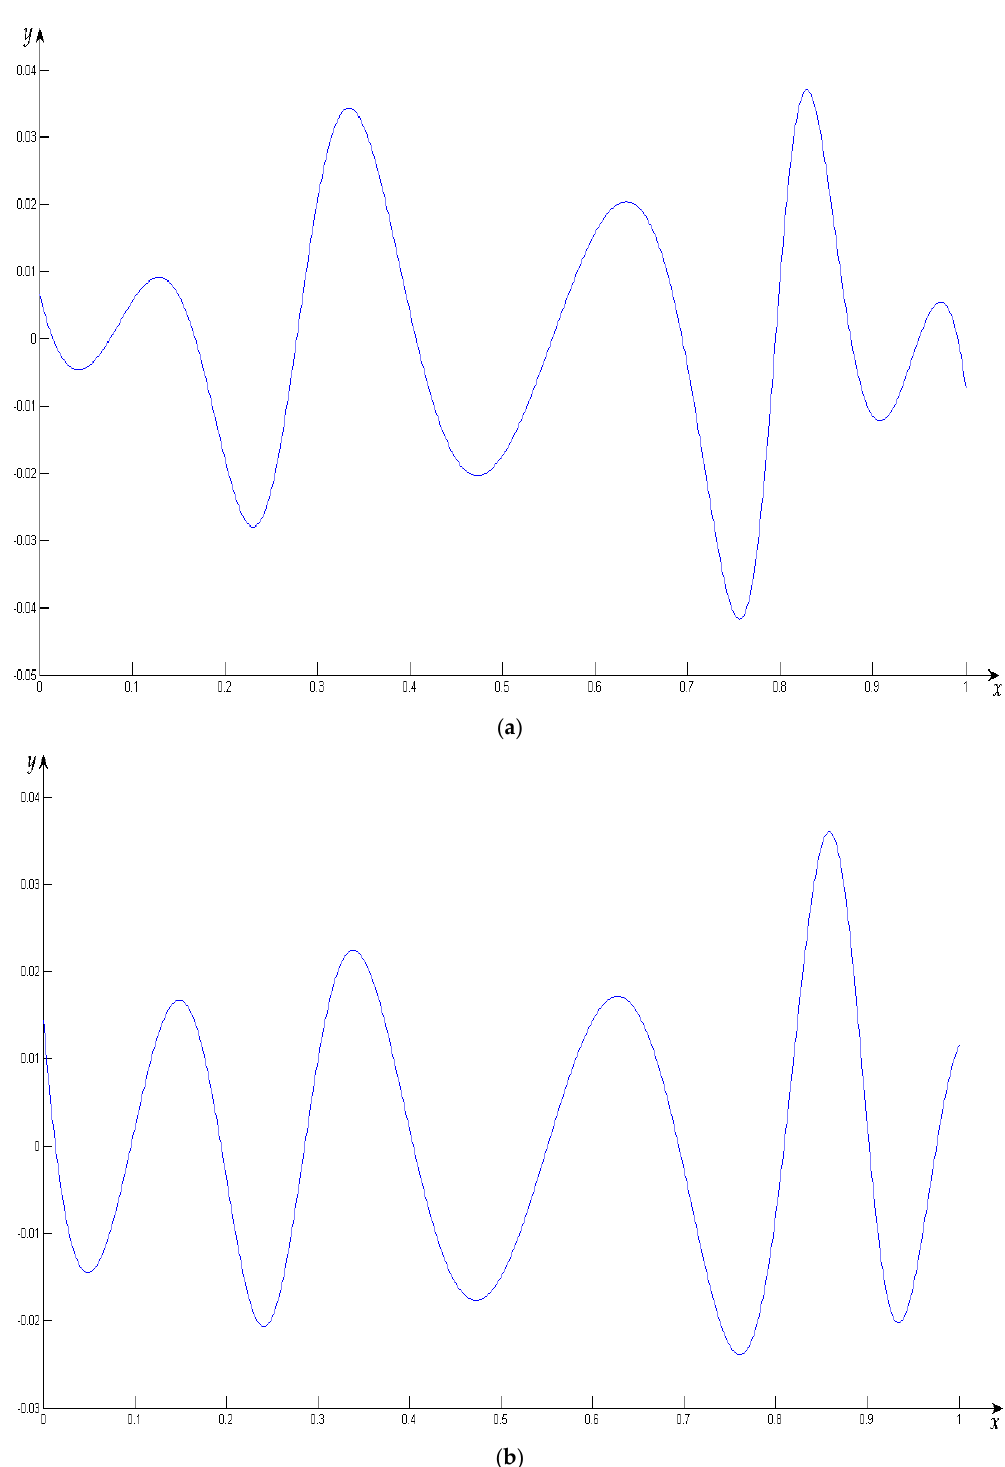
Figure 4. Error curves of different approximation methods. ( a ) Interpolating algorithm; ( b ) Algorithm in this paper after the second